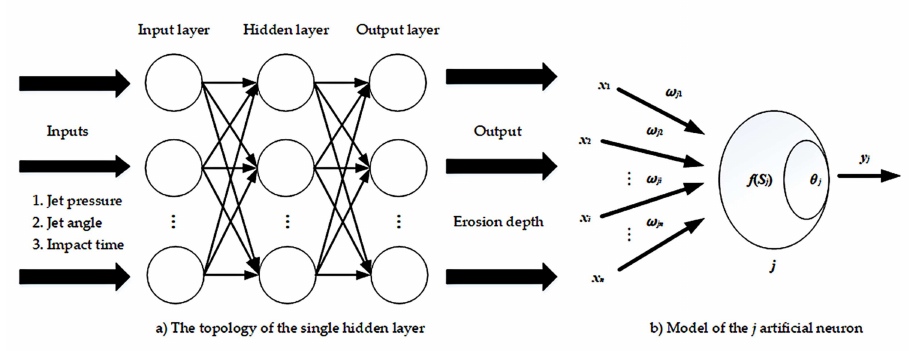
Figure 8. Prediction model of a back-propagating (BP) neural network: ( a ) The topology of the single hidden layer, ( b ) Model of the j artificial